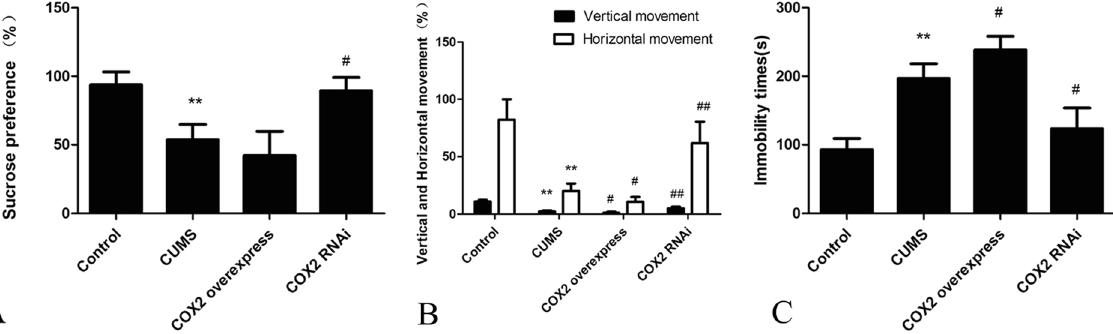
Figure 5. Effects of COX2 overexpression and RNAi on the changes in depressive-like behaviours in CUMS rats. ( A ) The sucrose preference (%). ( B ) The vertical and horizontal movements (%). ( C ) The immobility time(s). Group data shows the changes in the behaviour of rats. Data are expressed as the mean ± SD in six separate experiments. Compared with those in the control group, the sucrose preference, the vertical and horizontal movements of rats significantly decreased, whereas the immobility time significantly increased in the CUMS rats. Compared with that in the CUMS group, the sucrose preference and the horizontal and vertical scores were decreased, while the immobility time was significantly prolonged in the COX2 overexpressed group, but there were no significant differences in sucrose preference. In the COX2 RNAi group rats, the sucrose preference and the horizontal and vertical scores significantly increased, while the immobility time significantly decreased. ** P < 0.01 vs the control group. # P < 0.05 and ## P < 0.01 vs the CUMS group,